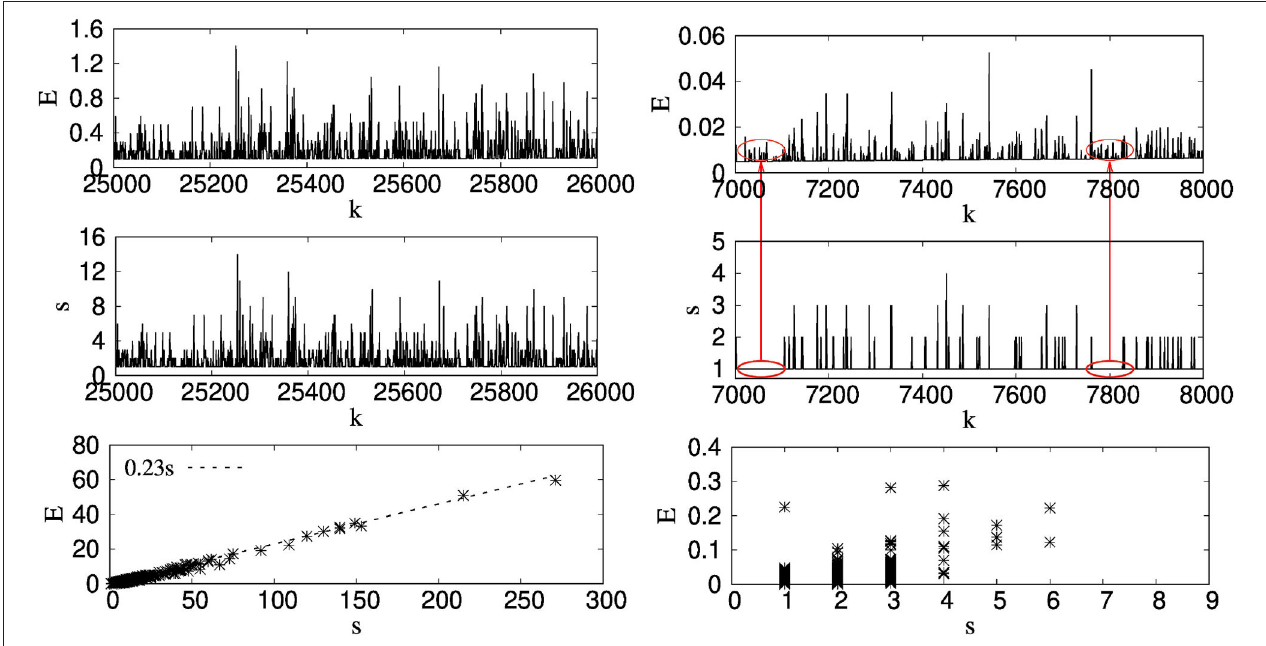
FIGURE 1 | The left panel, from top to bottom, shows the spectrum of energy values ( E ) with increasing number of avalanches k , avalanche sizes ( s ) with k and E vs. s for a certain avalanche for a GLS FBM. The right panel does the same but for a LLS FBM. We can see that, in case of a GLS FBM, there is a direct correspondence between the s and E values for a certain k . This means, higher s gives higher E . Since in case of GLS FBM, the fibers break in an increasing order of threshold values, we get, E ( k + 1) > E ( k ) even if s ( k + 1) = s ( k ). We do not see this direct correspondence between the s and E values with local load sharing scheme. For example, the red eclipses show the parts where only 1 fiber breaks at each k value but the corresponding E values show many different values without any particular order as the fibers themselves do not follow any order while breaking. This uncorrelated behavior between s and E